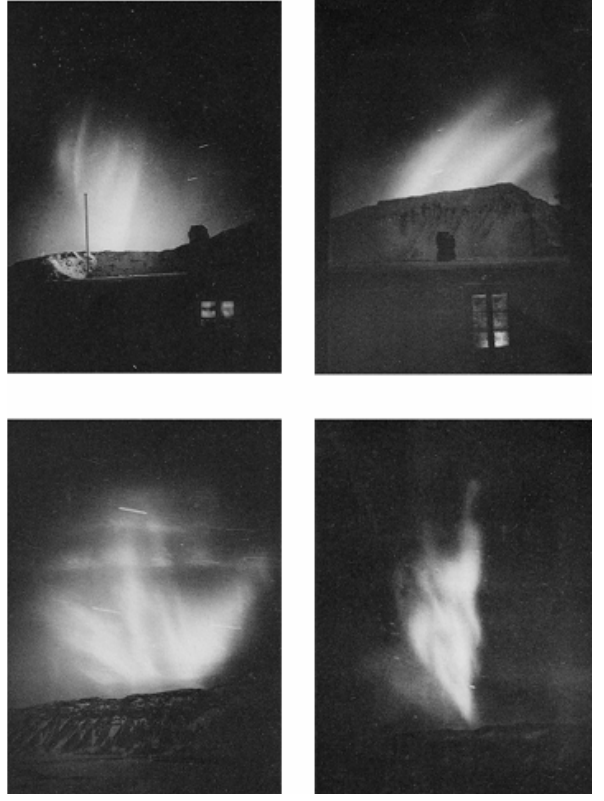
Fig. 7. Auroral photos obtained from the Spitsbergen Archipelago in 1899. Figure 7. Auroral photos obtained from the Spitsbergen Archipelago in 1899.